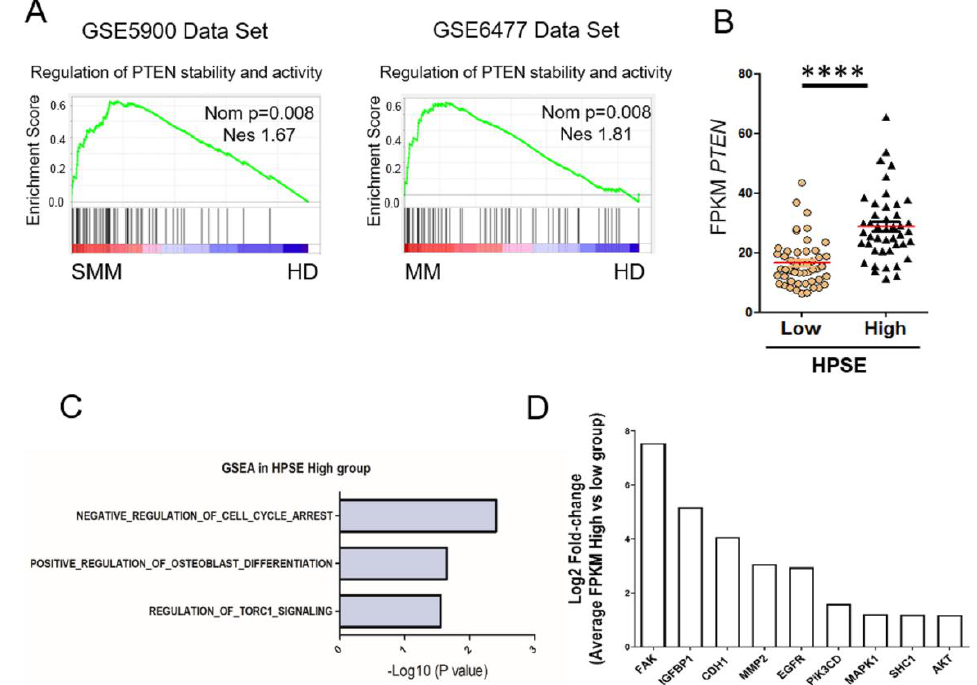
Figure 3. PTEN stability and activity are upregulated in myeloma. ( A ) GSEA analysis of datasets comparing healthy donors (HD) to smoldering myeloma patients (SMM) and healthy donors to multiple myeloma patients (MM). PTEN signatures were enriched in patients compared to healthy donors (red bar tracks high enrichment, blue bar tracks low enrichment of genes in the signature). Nominal p -value (Nom p ) and normalized enrichment score (NES) were displayed for every GSEA analysis (MM, multiple myeloma; SMM, smoldering multiple myeloma). ( B ) Expression of PTEN in patients from the HPSE-high and HPSE-low group (as shown in Figure 2B), **** p < 0.0001 by one-tailed, impaired t -test. Comparison of myeloma tumor cells from the HPSE-high patient group versus the HPSE-low group reveals elevated expression in the HPSE-high group of gene sets ( C ) and genes ( D ) known to be correlated with downregulation of PTEN activity (log2 transformation of fold change of the relative FPKM expression in ( D ) comparing HPSE-high group with low group).